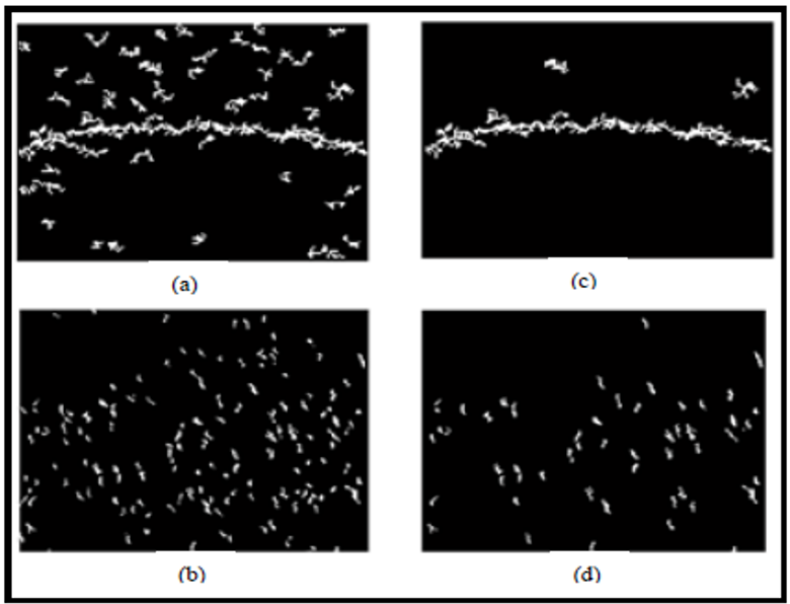
Figure 5. Region of Interest Extraction ( a ) Binarized transverse crack ( b ) Image without crack, ( c , d ) Noise